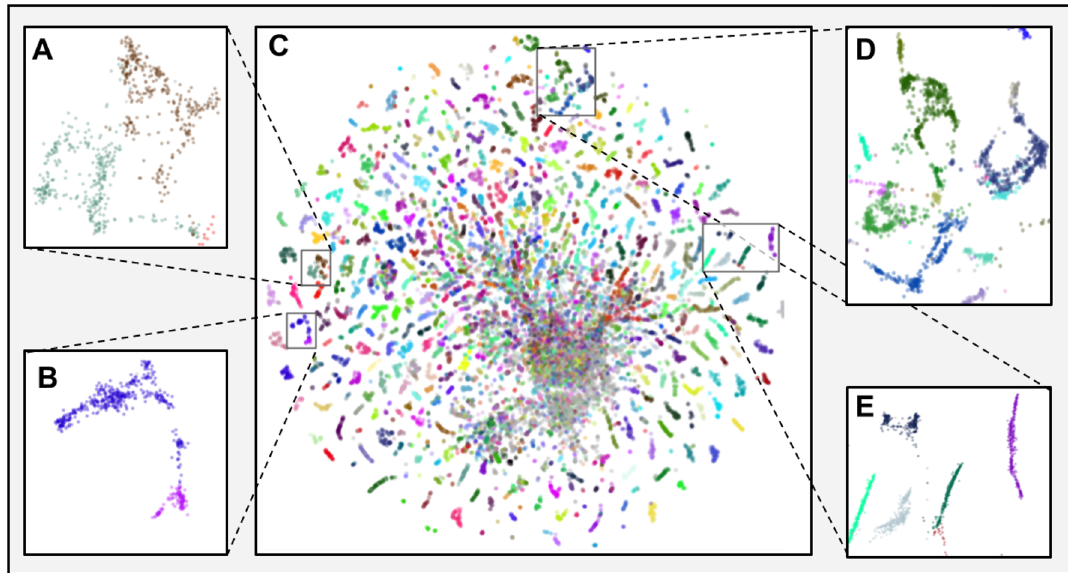
Figure 4. Deep embeddings UMAP projection of Bacterial SwissProt colored by KO. (A) transferase proteins that share the same Pfam domain and belong to the EC 2.5.1 class—UDP-N-acetylglucosamine 1-carboxyvinyltransferase (K00790) in dark green, 3-phosphoshikimate 1-carboxyvinyltransferase (K00800) in brown. (B) GTP binding proteins sharing Pfam domains—Elongation Factor G (K02355) in purple, Peptide chain release factor (K02837) in pink. (C) All Bacterial SwissProt proteins. (D) proteins that belong to the tRNA ligases class (EC 6.1.1)—Cysteine (K01883) in dark green, Arginine (K01887) in blue, Glutamate (K01885) in navy blue, Glutamine (K01886) in cyan,Valine (K01873) in pink, and Isoleucine (K01870) in light green. (E) ribosomal proteins—30S ribosomal protein S1 (K02961) in light green, 50S ribosomal protein L14 (K02874) in light blue, 50S ribosomal protein L36 (K02919) in black, 50S ribosomal protein L35 (K02916) in dark green, and 50S ribosomal protein L15 (K02876) in